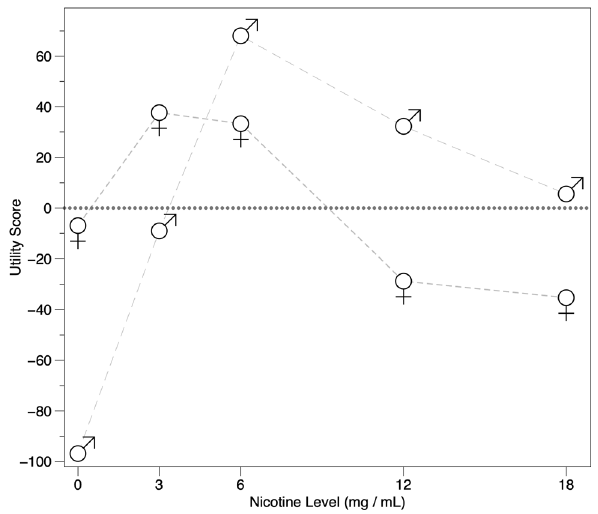
Figure 3. Utility scores for the five nicotine levels provided within the choice task. When split by gender, the preferred nicotine level for women was lower than the preferred level chosen by men. Elements with positive scores are shown above the dotted line, while negative scores fall below the dotted